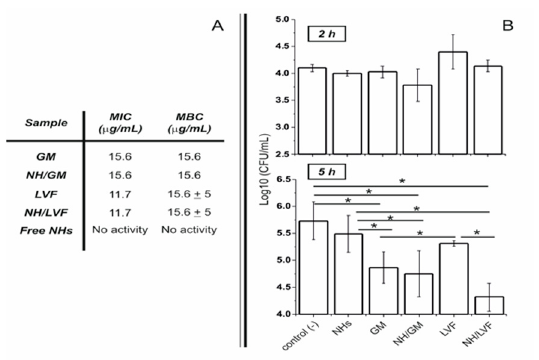
Figure 8. MIC of GM/NHs or LVF/NHs against planktonic ( A ) or intracellular ( B ) S. aureus in HaCaT. Figure 8. MIC of GM / NHs or LVF / NHs against planktonic ( A ) or intracellular ( B ) S. aureus in